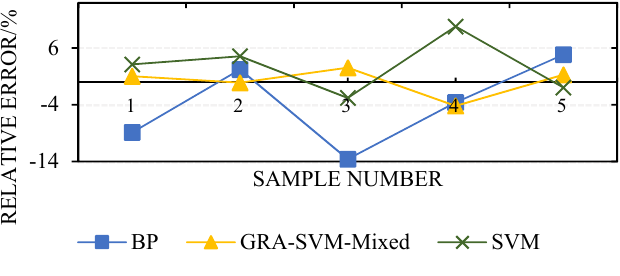
Figure 6. Comparison of values of different models. Table 6. Comparison of predictive performance of different models.